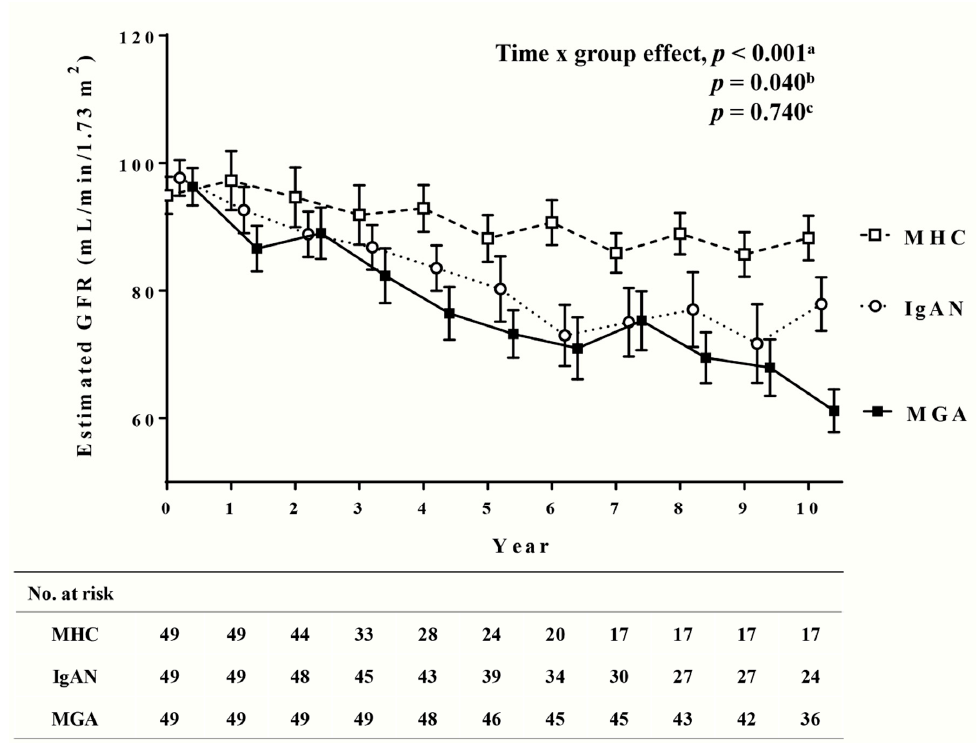
Figure 2. Changes in the estimated glomerular filtration rate (eGFR) in the minor glomerular Figure2. Changesintheestimatedglomerularfiltrationrate(eGFR)intheminorglomerularabnormality abnormality (MGA), matched healthy control (MHC), and immunoglobulin A nephropathy (IgAN) (MGA), matched healthy control (MHC), and immunoglobulin A nephropathy (IgAN) groups in the groups in the 10 years after kidney biopsy. Time effects were tested using a linear mixed model. 10 years after kidney biopsy. Time e ff ects were tested using a linear mixed model. a MGA and MHC a MGA and MHC groups; b MHC and IgAN groups; c MGA and IgAN groups. groups; b MHC and IgAN groups; c MGA and IgAN groups.